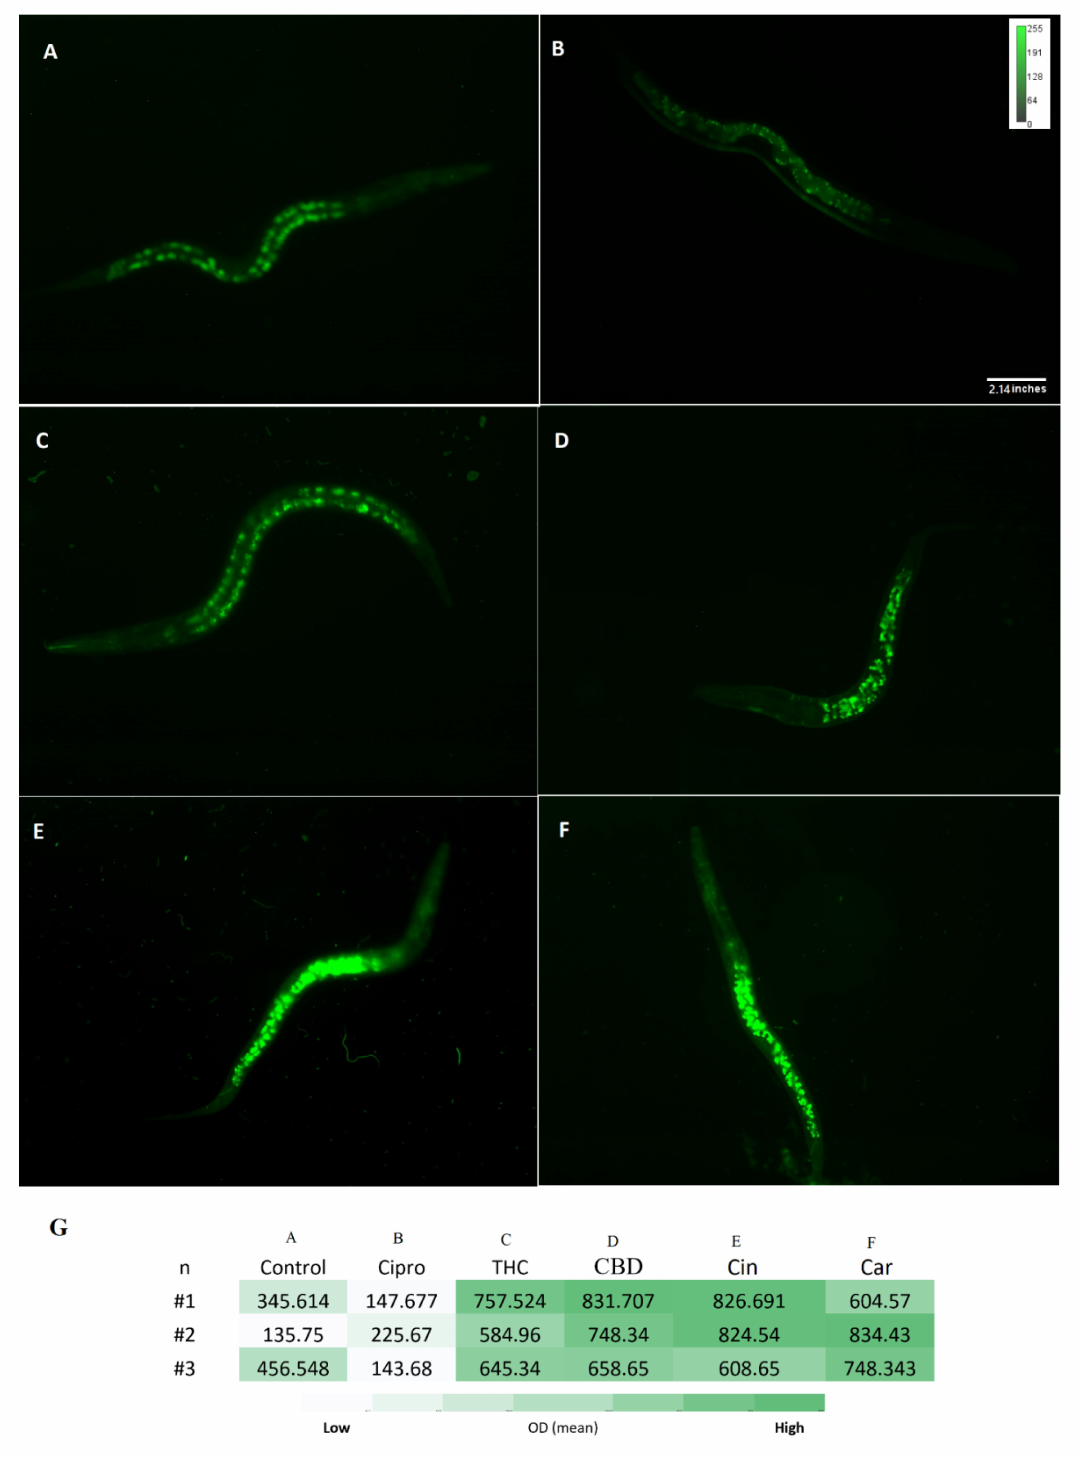
Figure 7. NDA staining for reduced glutathione level. Fluorescence intensity of all C. elegans GSH levels was measured after exposure to control (PBS) ( A ), ciprofloxacin ( B ), THC ( C ), CBD ( D ), cinnamaldehyde ( E ), and carvacrol ( F ) by NDA probe. Heatmap on glutathione level of C. elegans in the treated and untreated groups shown in panel ( G ). n = trial